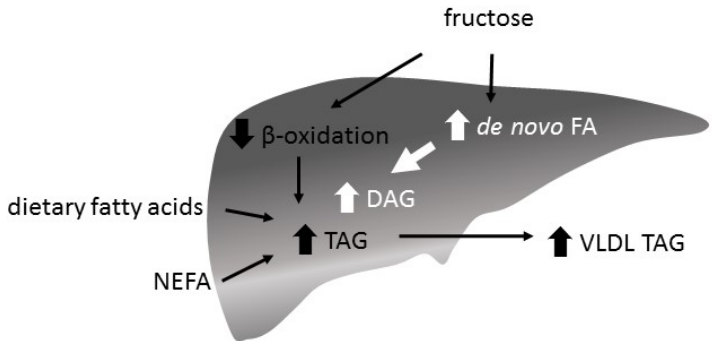
Figure 5. Hepatic triglyceride (TAG) synthesis and very low density lipoprotein (VLDL) secretion. The abundance of fatty acids (FA) in the liver is given by the plasma concentration of dietary FA and non esterified fatty acids (NEFA) and the amounts of newly synthesized FA and beta oxidation rate. It is the main determinant of the hepatic TAG/VLDL secretion rate. FA are sequentially esterified with glycerol by different transferases and secreted as VLDL. Fructose decreases beta oxidation and increases hepatic FA/TAG content and VLDL